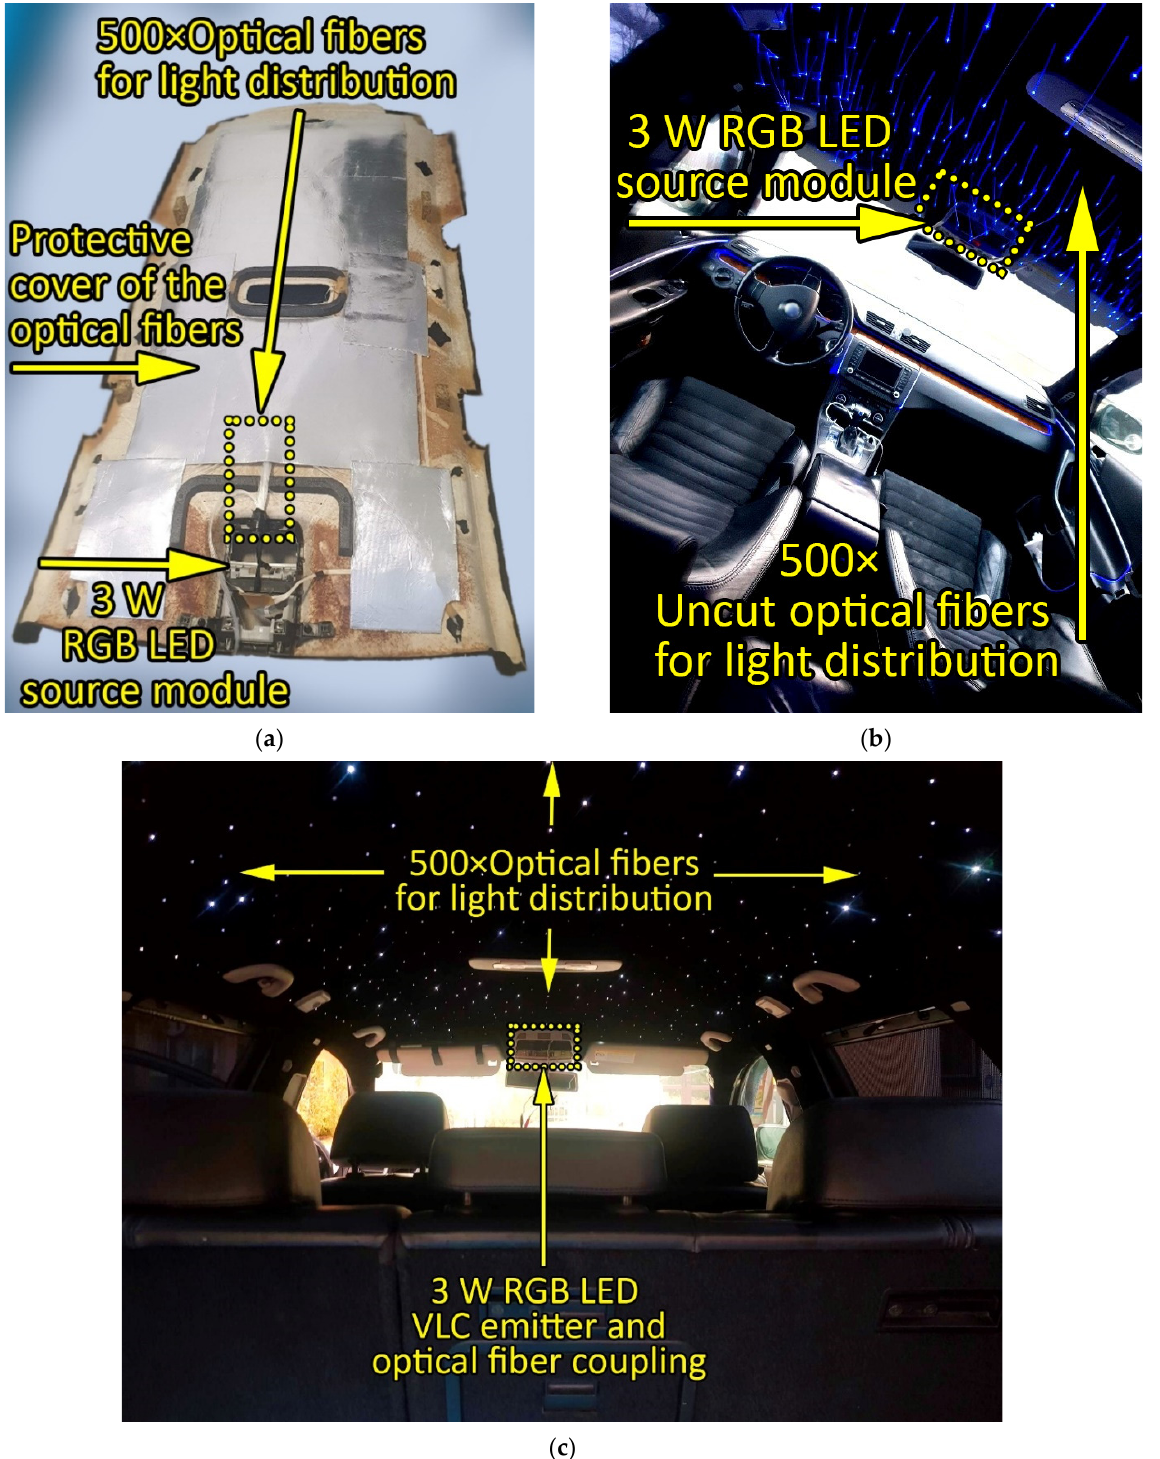
Figure 4. Hardware implementation of the ambient light in-vehicle visible light communications emitter: ( a ) installation of the optical fiber within the vehicle rooftop; ( b ) adjustment of the optical fiber within the vehicle rooftop; ( c ) final in-vehicle optical wireless data transmission system based on optical fiber distributed light.